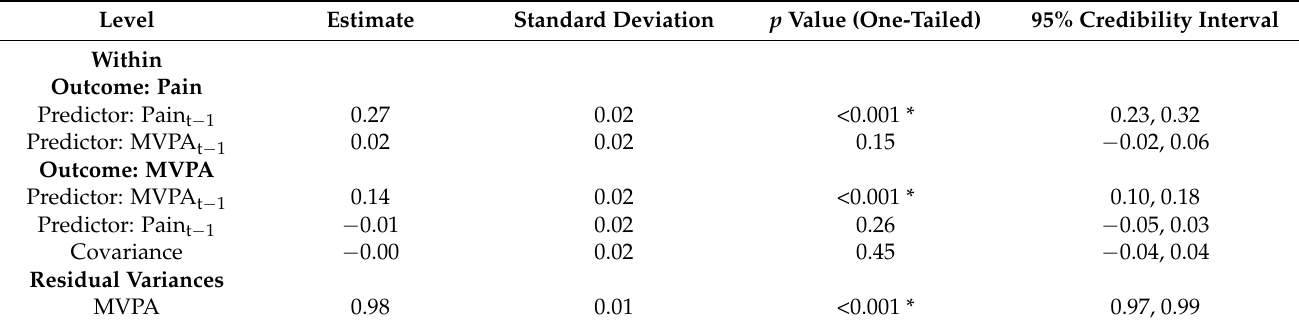
Table 3. MVPA Activity and Pain VAR (1) Model Standardized